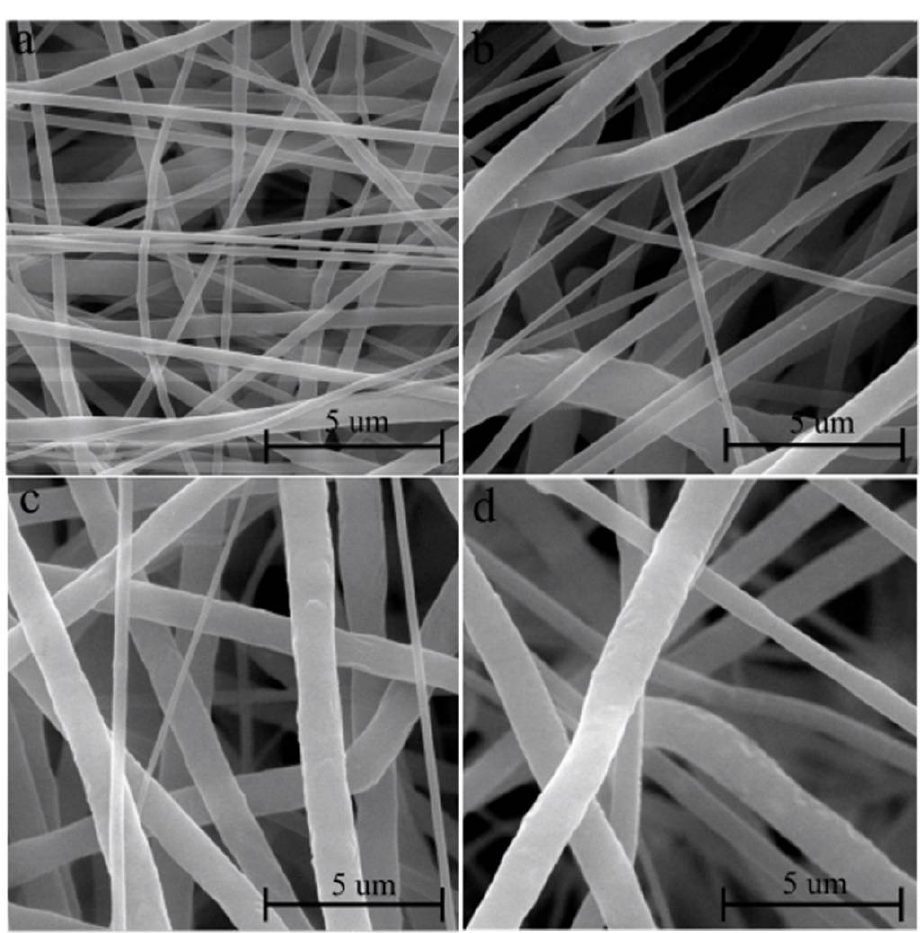
Figure 5. SEM micrographs of the fibrous scaffolds, ( a ): PCL, ( b ): 3MNP, ( c ): 5MNP, and ( d ): 10MNP.